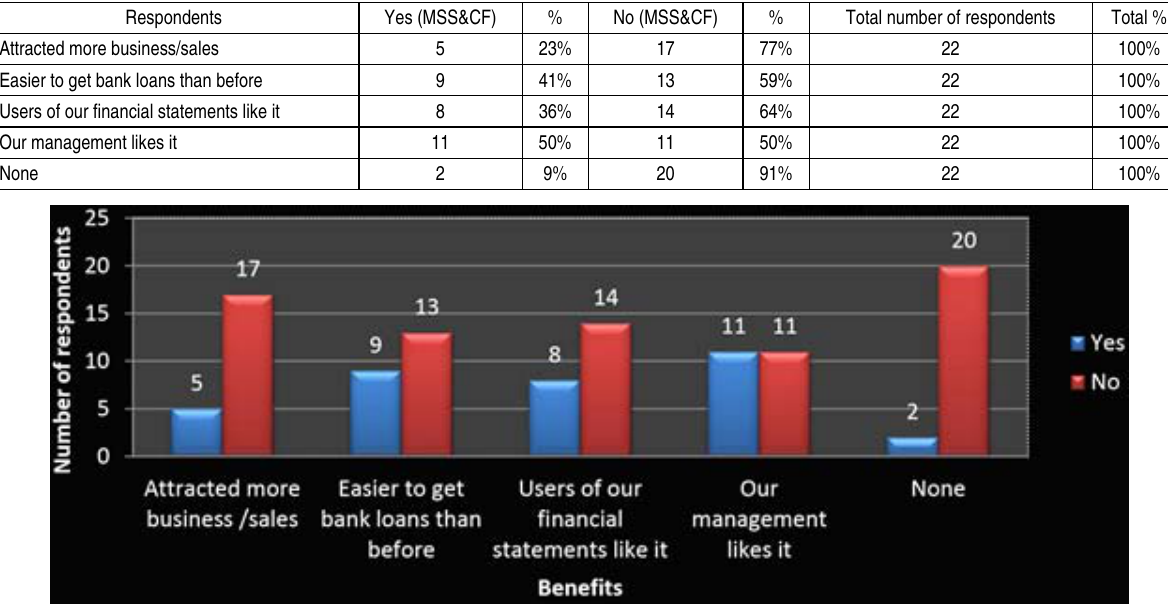
Fig. 4. Challenges of implementing IFRS for SMEs Table 4. Benefits of using IFRS for SMEs